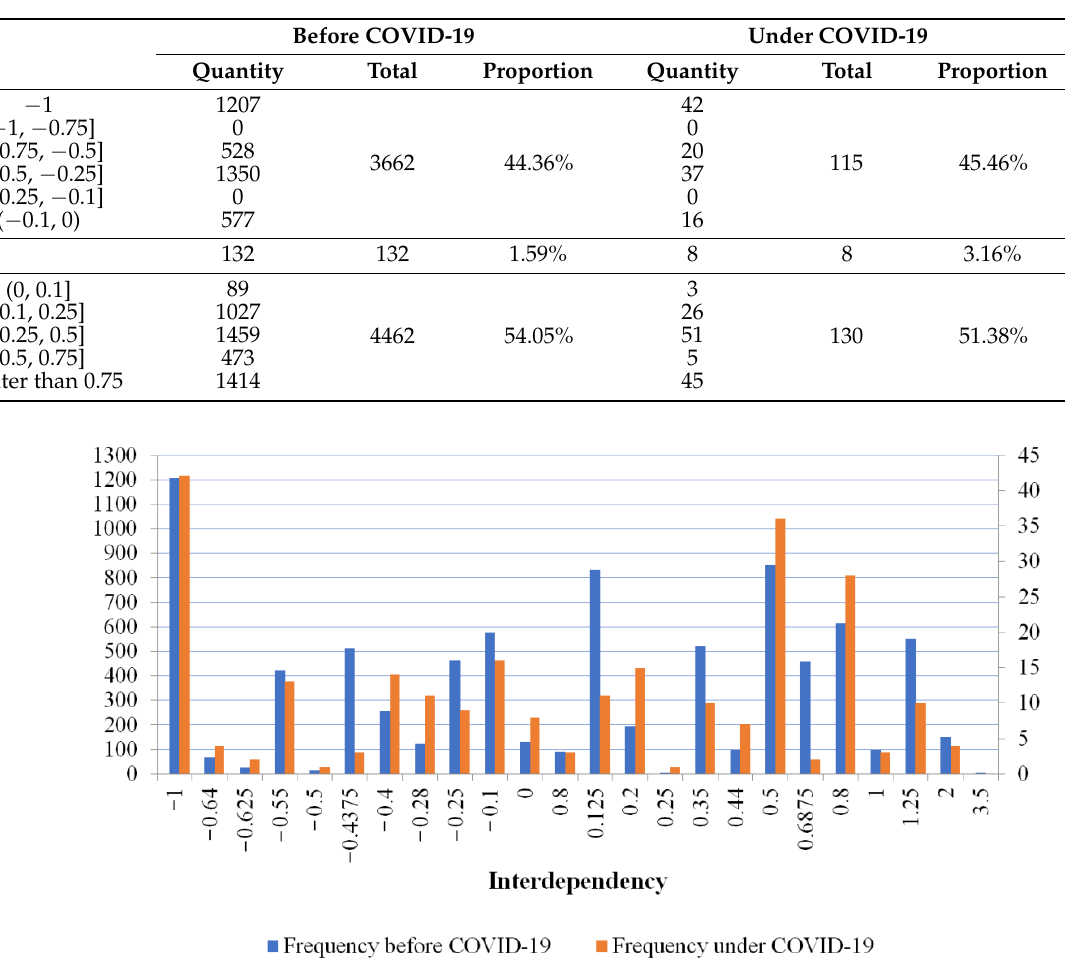
Figure 4. Frequency of the interdependencies before and under the lockdown of COVID-19.